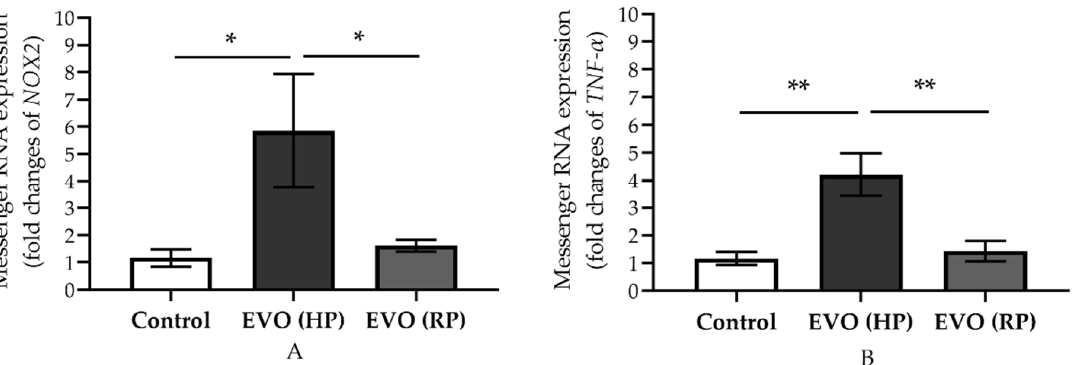
Figure 5. Messenger RNA expression of prooxidant gene ( NOX2 ; A ) and proinflammatory cytokine ( TNF- α , B ) in retina. EVO: episcleral vein occlusion; HP: high intraocular pressure; RP: recovered intraocular pressure. Control group refers to the sham group. Values are expressed as mean ± SEM (* p < 0.05, ** p < 0.01; n = 5–6 per group).